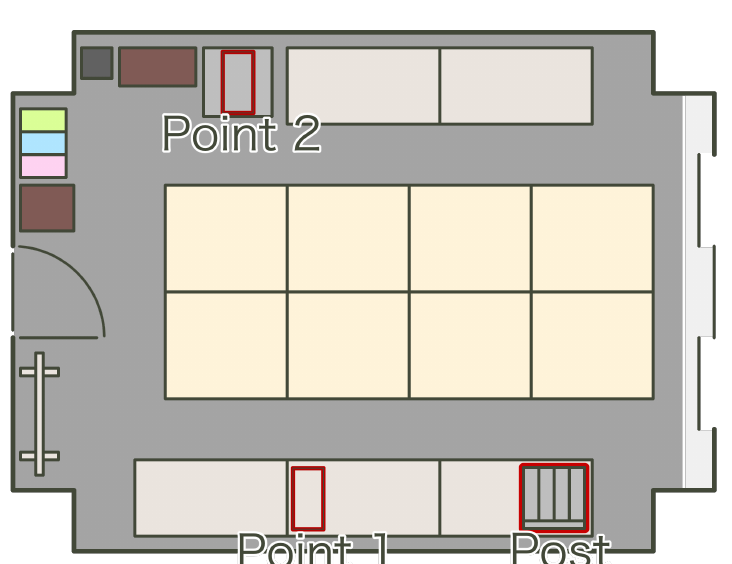
Figure 8. Experimental environment; in this experiment, the beacons are the points transported by